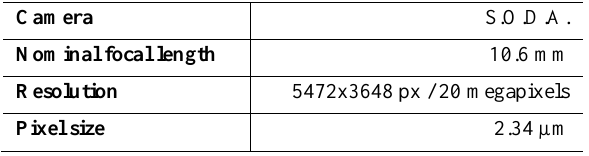
Table 1. Main sensor characteristics.